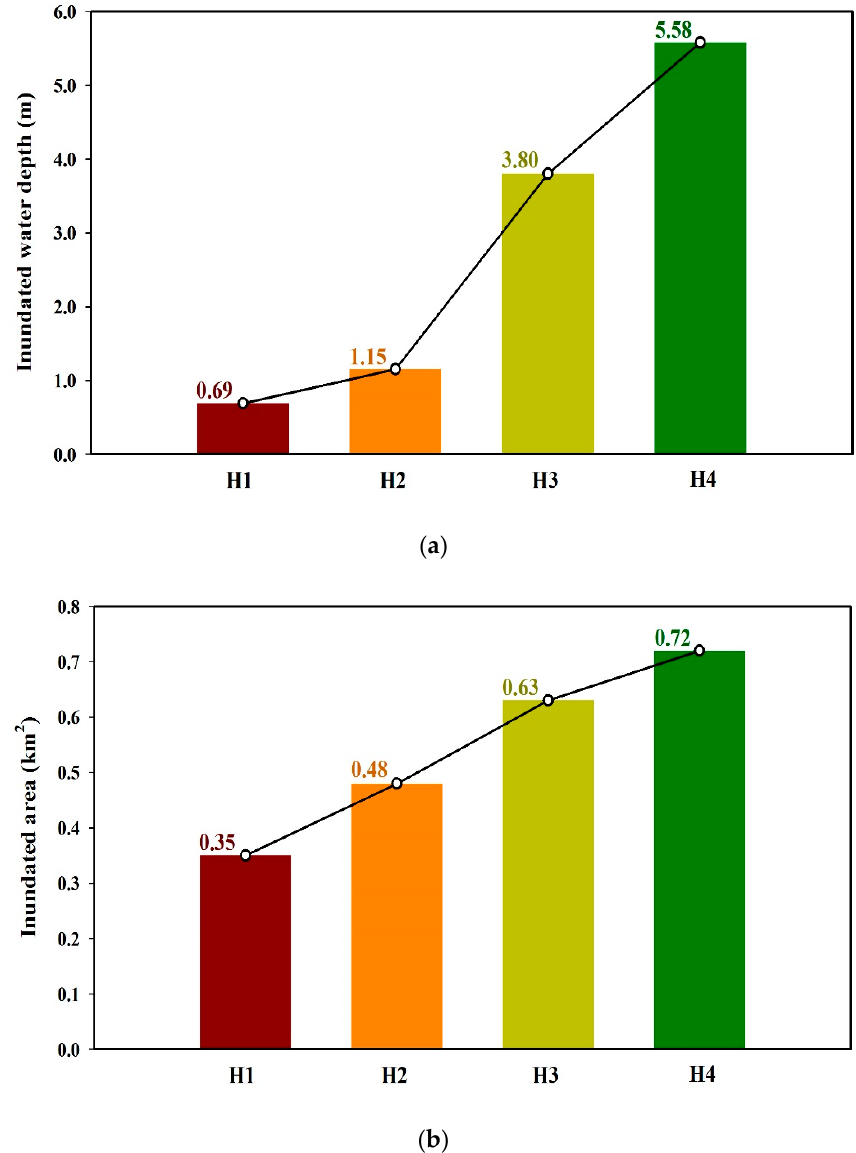
Figure 13. Comparison of ( a ) maximum inundated water depths and ( b ) inundated area in the four scenarios of the flood inflow rate.